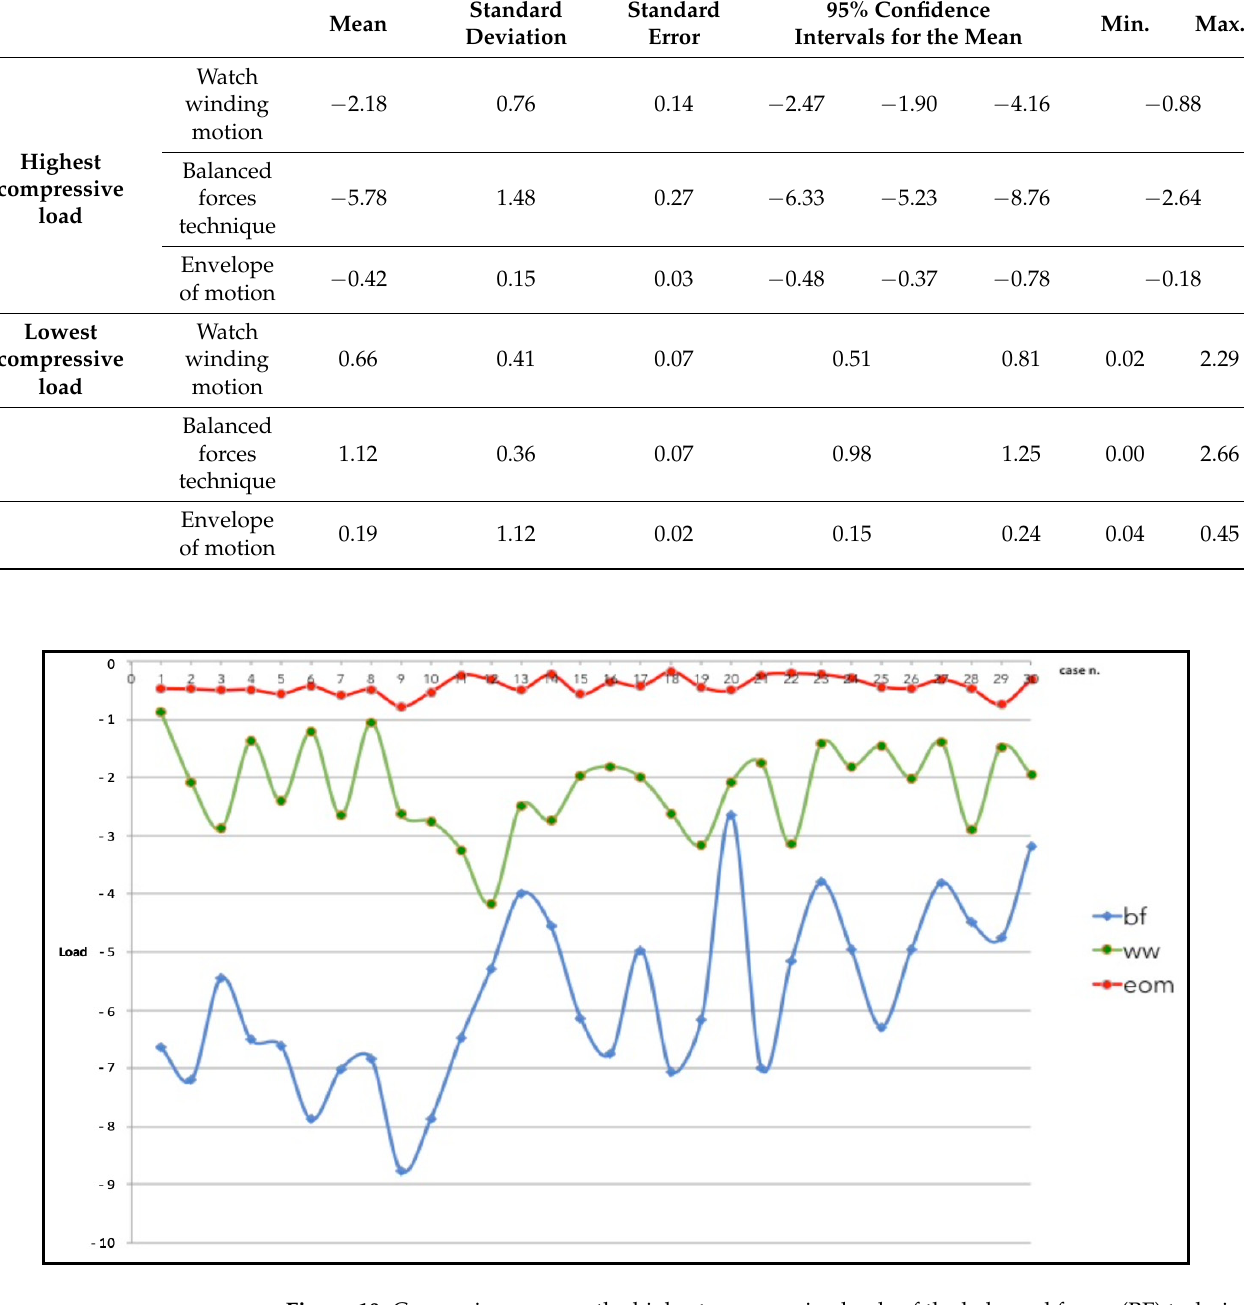
Figure 11. Estimated prediction means of the balanced forces (BF) technique, watch winding (WW) motion, and the envelope of motion (EOM) by the highest and lowest compressive loads with 95% confidence intervals.